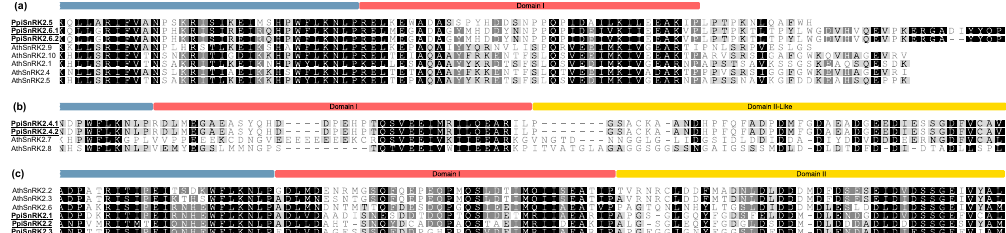
Figure 3. M-Coffee alignments of P. pinaster PpiSnRK2 and Arabidopsis SnRK2 sequences (AthSnRK2) focused on the C-terminal region of these kinases containing the regulatory domains I and / or II: ( a ) Group I SnRK2; ( b ) Group II SnRK2 and ( c ) Group III SnRK2. All pine PpiSnRK2 regulatory sequences showed high resemblance to the Arabidopsis sequences into their respective groups including PpiSnRK2.4 isoform, with conserved aspartate residues at positions corresponding with those of Arabidopsis SnRK2(II) sequences regulatory domain II.